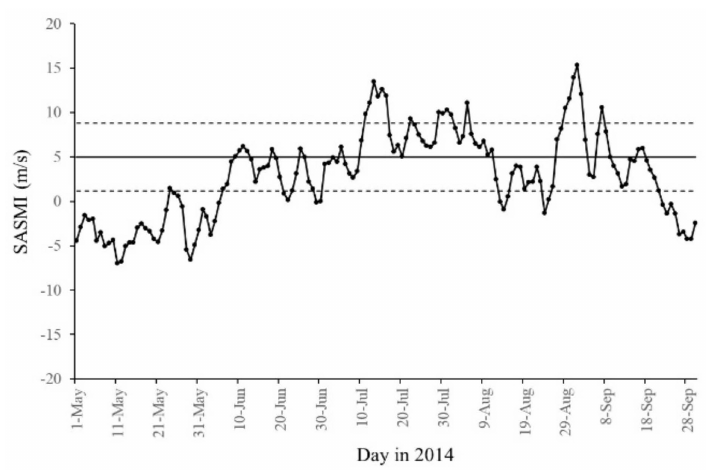
Figure 2. Variations in the SASM index (SASMI), with the averaged SASMI value (5.0 m/s) shown as a solid line, dashed lines represent one standard deviation (3.8 m/s) above and below the mean